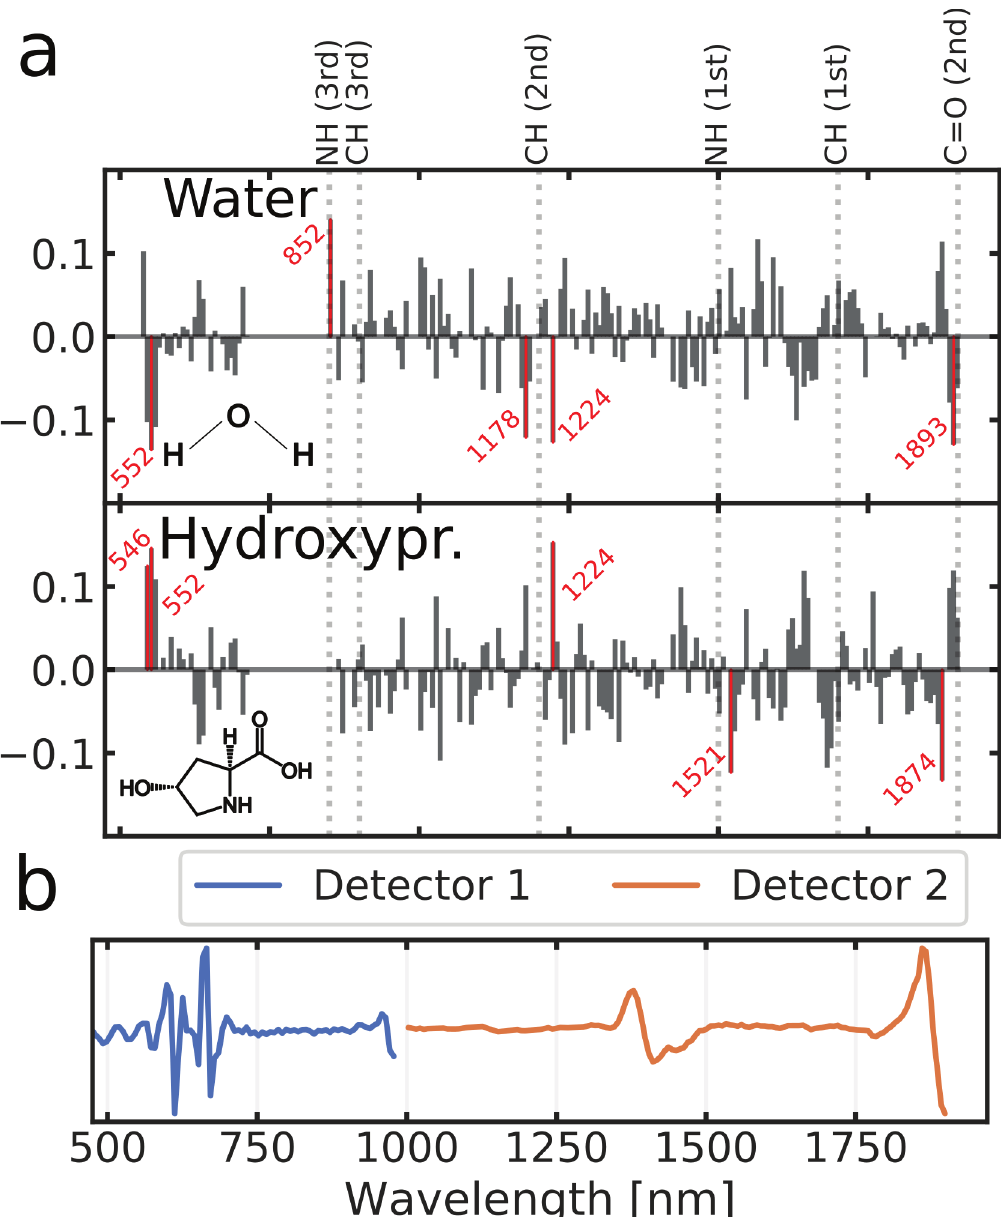
Fig 6. Feature importance of the predictive models. a : Coefficients of the PLS models for water and hydroxyproline content. The five most influential wavelengths (in terms of absolute magnitude) have been highlighted in red. b : Spectrum used as input for the water and hydroxyproline models. Spectra from detector 1 was smoothed with a 3rd order polynomial Savitzky- Golay filter using a 18 nm filtering window and the second spectral derivative. Similar treatment was applied to spectra from detector 2 with the exception of filtering window being set to 58 nm. Spectra from detector 1 was limited to the wavelength range of 370–980 nm and the spectra from detector 2 to 1000–1900 nm. be predicted with NIRS. In quasi-static loading, the ligament was slowly stretched until the fail- ure point with the resulting stress-strain curve describing toe region, linear region, yield, and failure characteristics of the sample. The properties related to the yield and failure point of the ligament could be predicted with higher accuracy than the other mechanical properties.